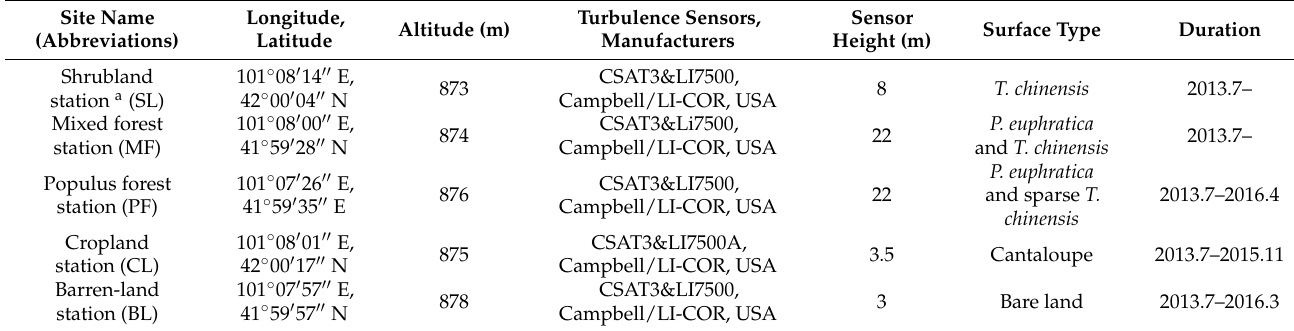
Table 1. Details of the eddy-covariance systems at each site within the intensive observation area in 2014.